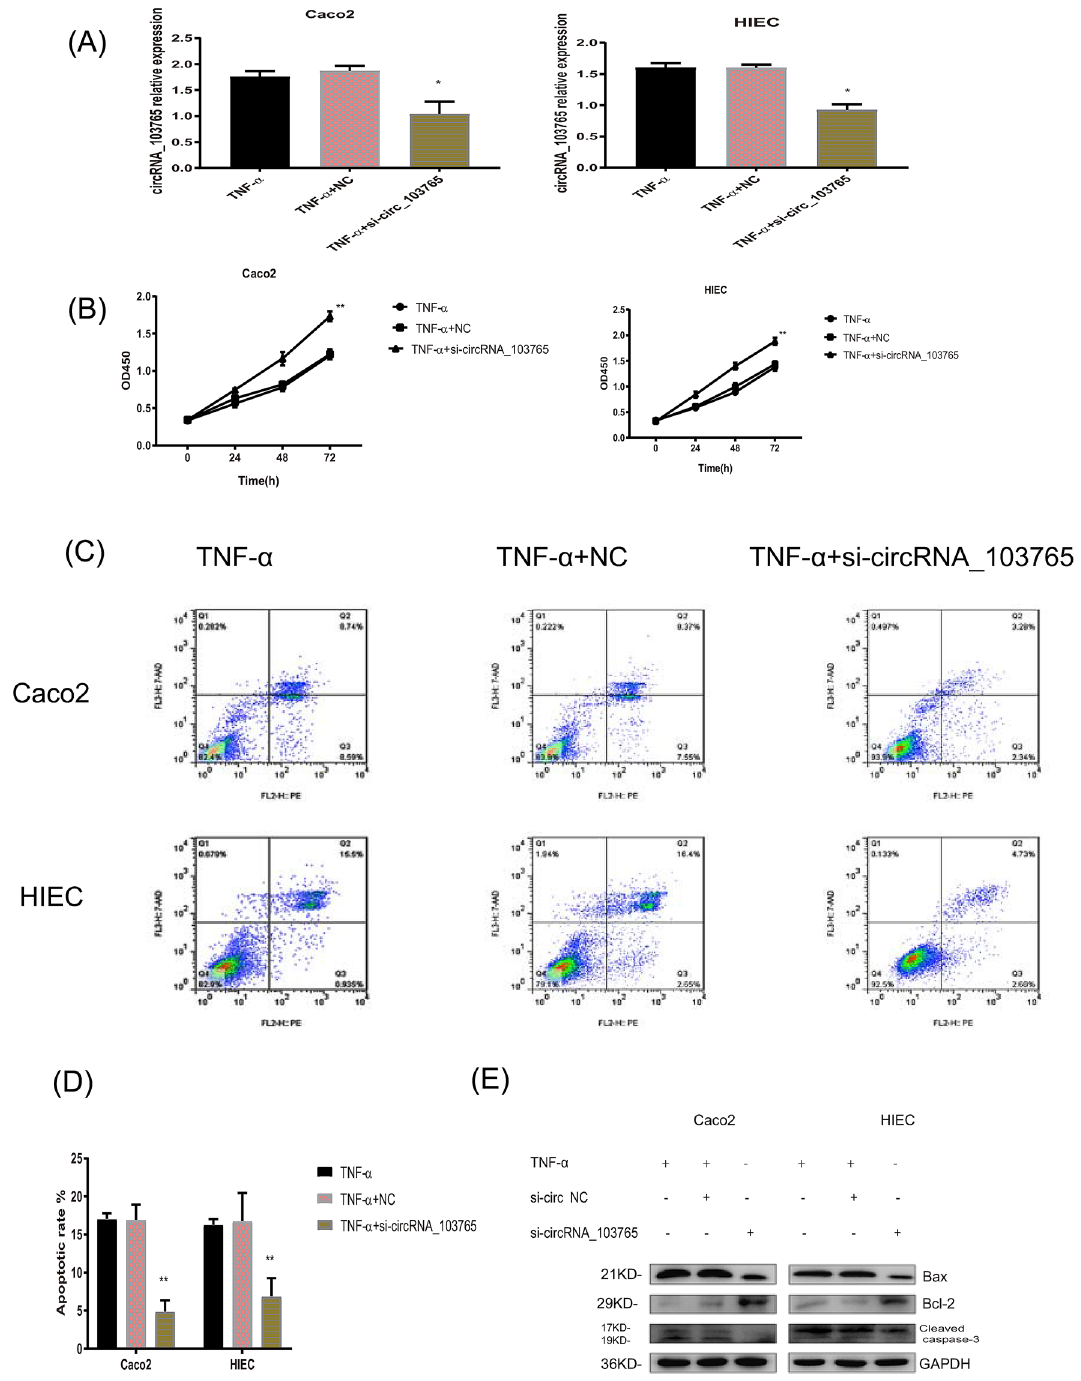
Figure 4. Knockdown of circRNA_103765 protects human intestinal epithelial cells from TNF-α-induced apoptosis. ( A ) Relative expression of circRNA_103765 in TNF-α stimulated Caco2 and HIEC cells treated with negative control siRNA (si-NC) or si- circRNA_103765. ( B ) CCK-8 assay of Caco2 and HIEC cells transfected with negative control siRNA (si-NC) or si-circRNA_103765 at the indicated days. ( C , D ) Apoptosis rate were analyzed by flow cytometry after treated with negative control siRNA (si-NC) or si-circRNA_103765. ( E ) The expression levels of apoptosis-related proteins were determined by western blot. *p < 0.05, **p <